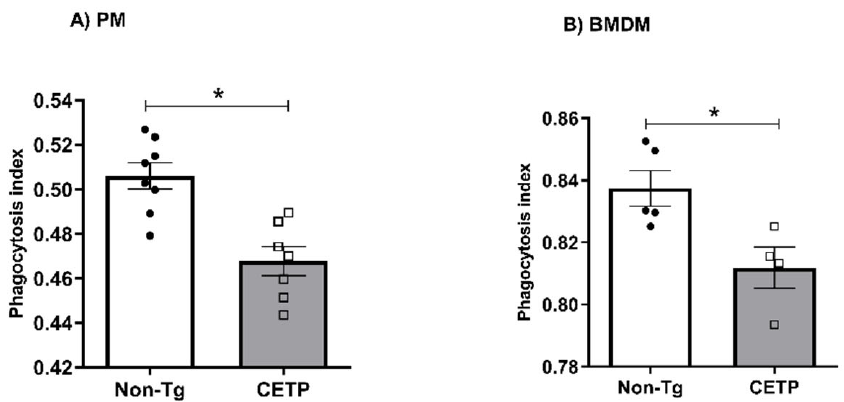
Figure 5. Macrophages expressing CETP have reduced phagocytosis. Phagocytic activity measured in thioglycolate-elicited peritoneal macrophage (PM) ( A ) and in bone marrow derived macrophage (BMDM) ( B ) from human CETP-Tg and non-transgenic mice (Non-Tg). * p < 0.05.